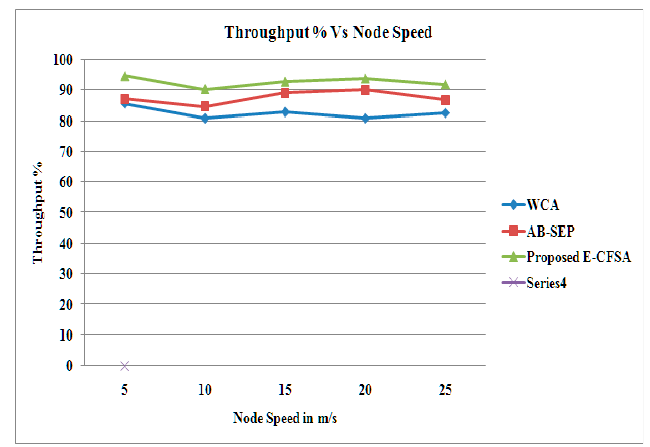
Figure 19. Graph Throughput Vs. No. of Nodes.